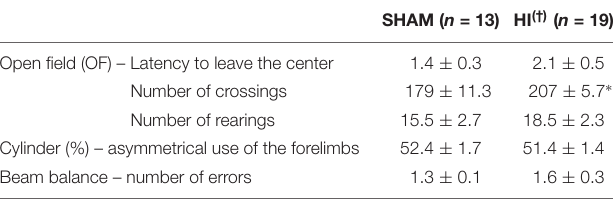
TABLE 1 | Summary of behavioral analysis in the open field, beam balance errors, and asymmetrical use of forelimbs in the Cylinder